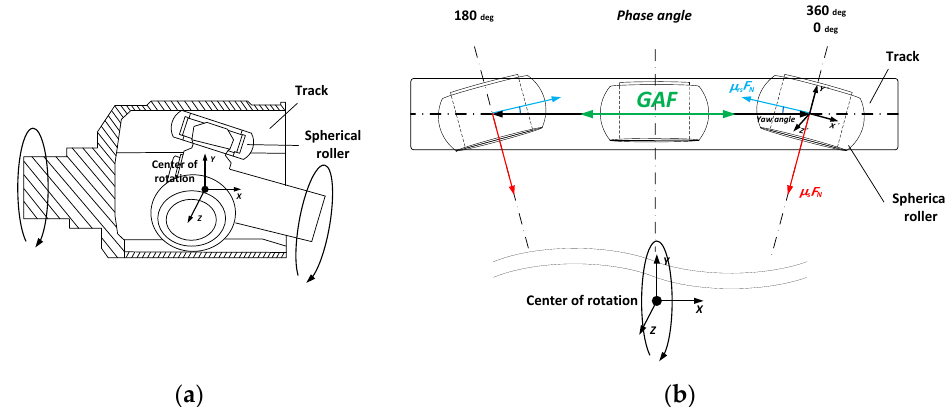
Figure 3. Motions between spherical roller and track ( a ) motion in assembly ( b ) spherical roller motion with respect to track.